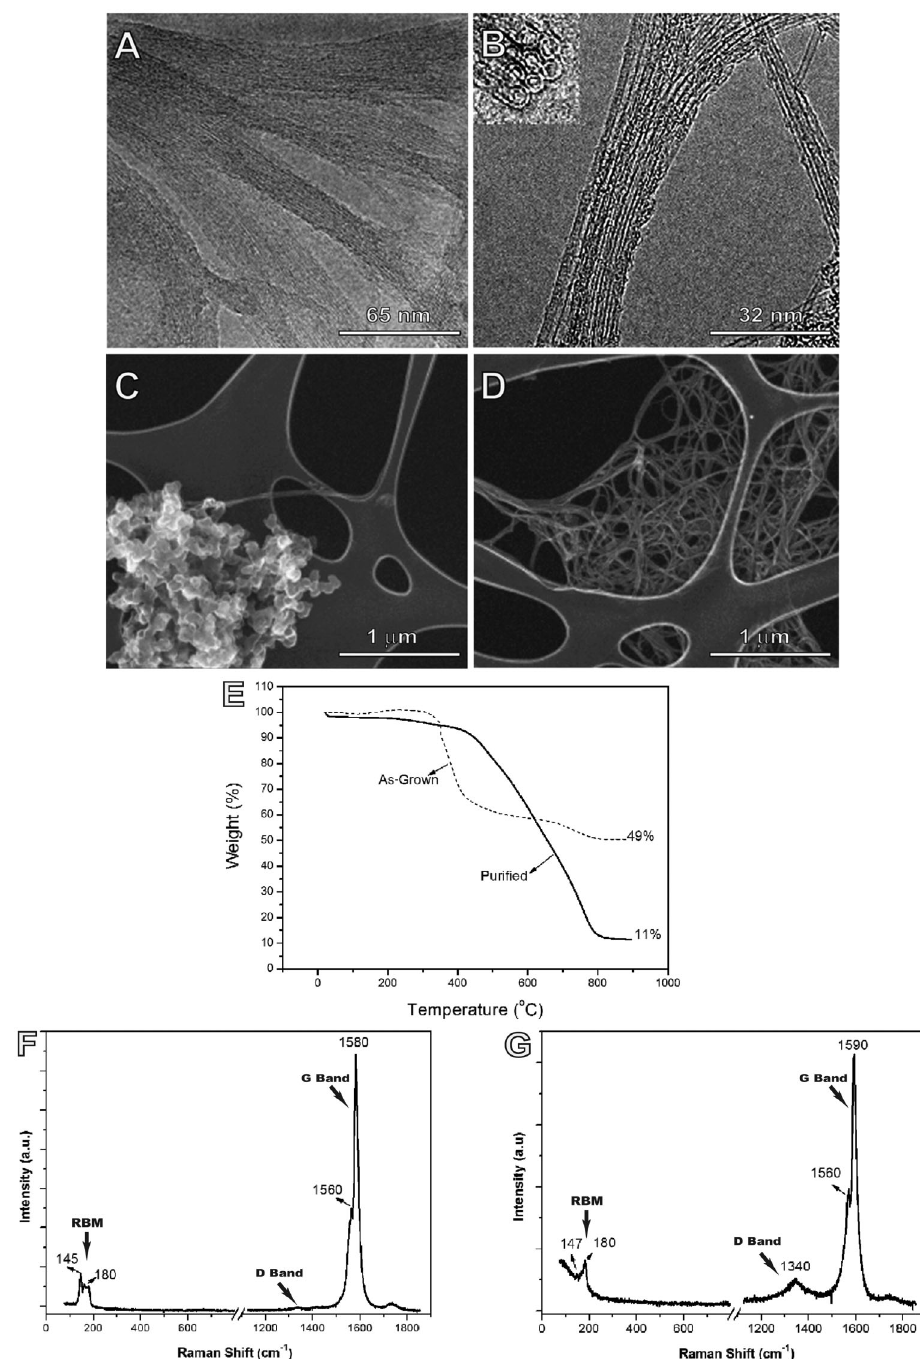
Figure 1. High-resolution transmission electron microscopies ( A and B ) show morphology and few defects in walls of single-wall carbon nanotubes (CNTs) following purification process. Insert in B represents CNTs viewed transversally. C and D , Scanning electron microscopy of CNT samples before ( C ) and after ( D ) the purification process. E , Thermogravimetric analysis of as-grown and purified CNTs. Dotted line represents mass loss of unpurified (as-grown) CNTs and continuous line corresponds to purified CNTs. Raman spectroscopy of CNTs showing low-frequency mode at 180 cm -1 , D band at 1340 cm -1 , and G band at 1580 cm -1 of unpurified (as-grown) CNTs ( F ) and purified CNTs ( G ). RBM: radial breathing mode; a.u.: arbitrary